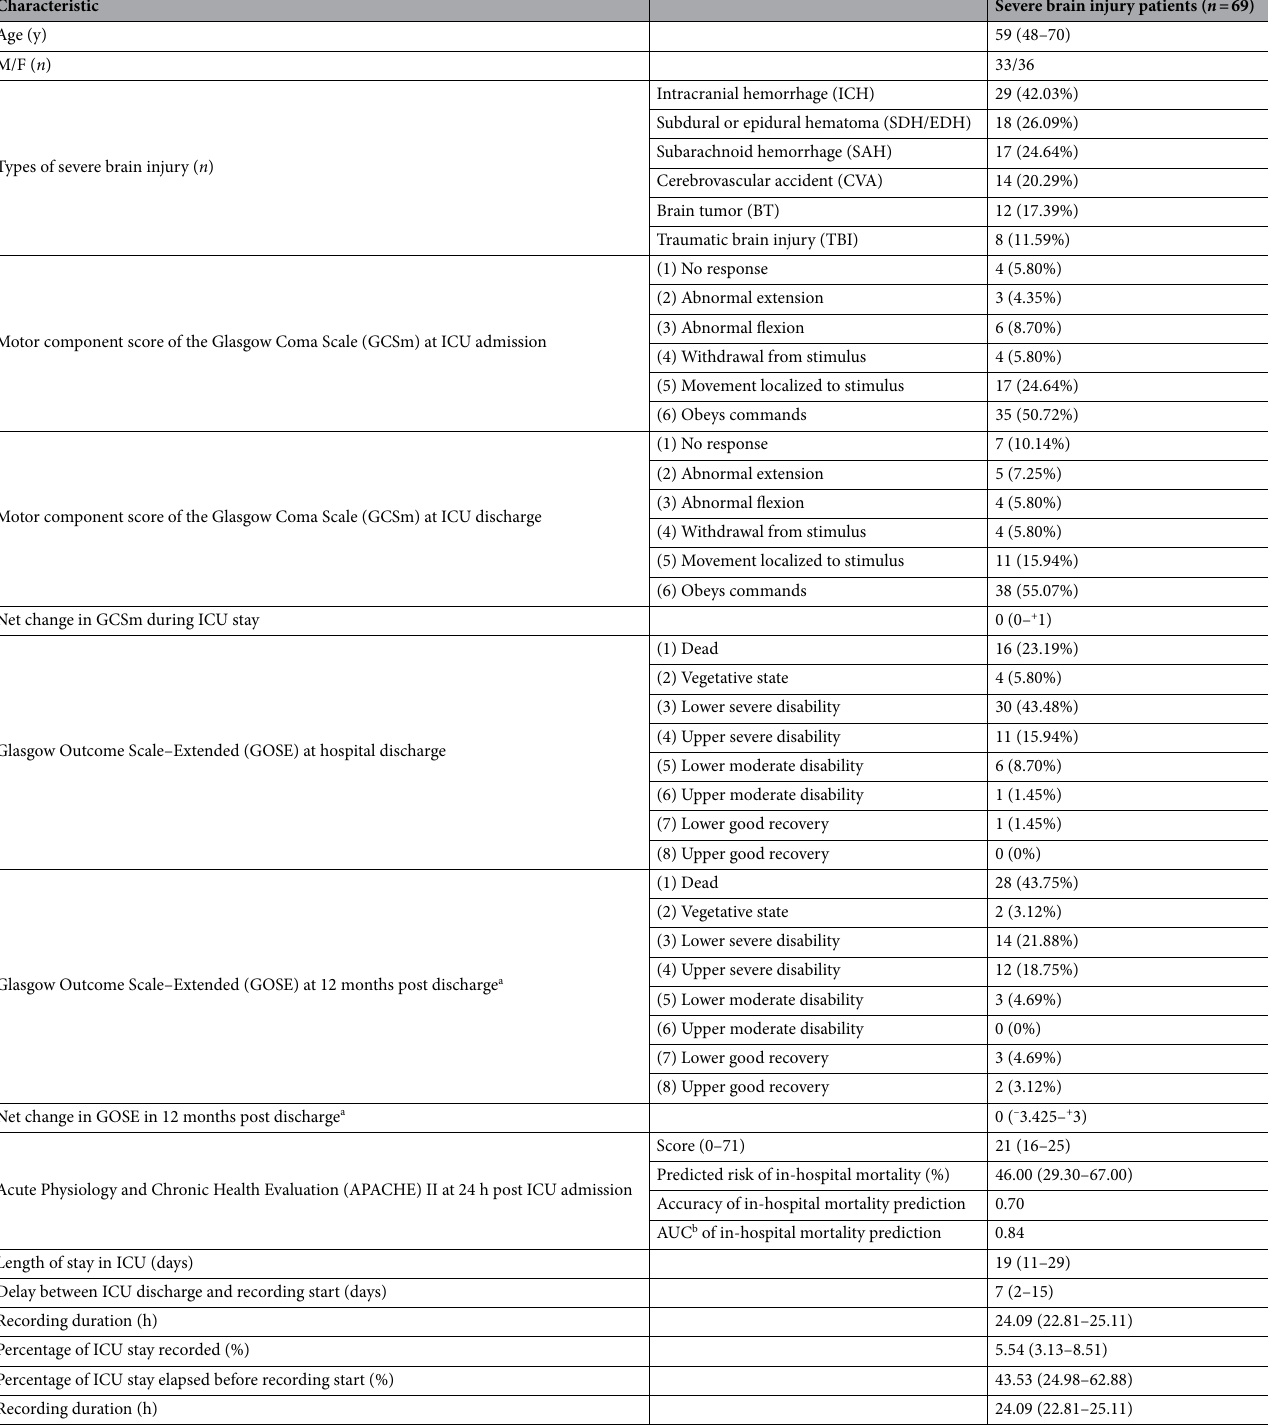
Table 1. Study population characteristics. Values represent medians with interquartile ranges (Q1–Q3) in parentheses or counts with percentages (%) in parentheses. a Total sample size at 12 months post discharge is n = 64. b Area under the receiver operating characteristic curve, i.e., the probability that the predicted